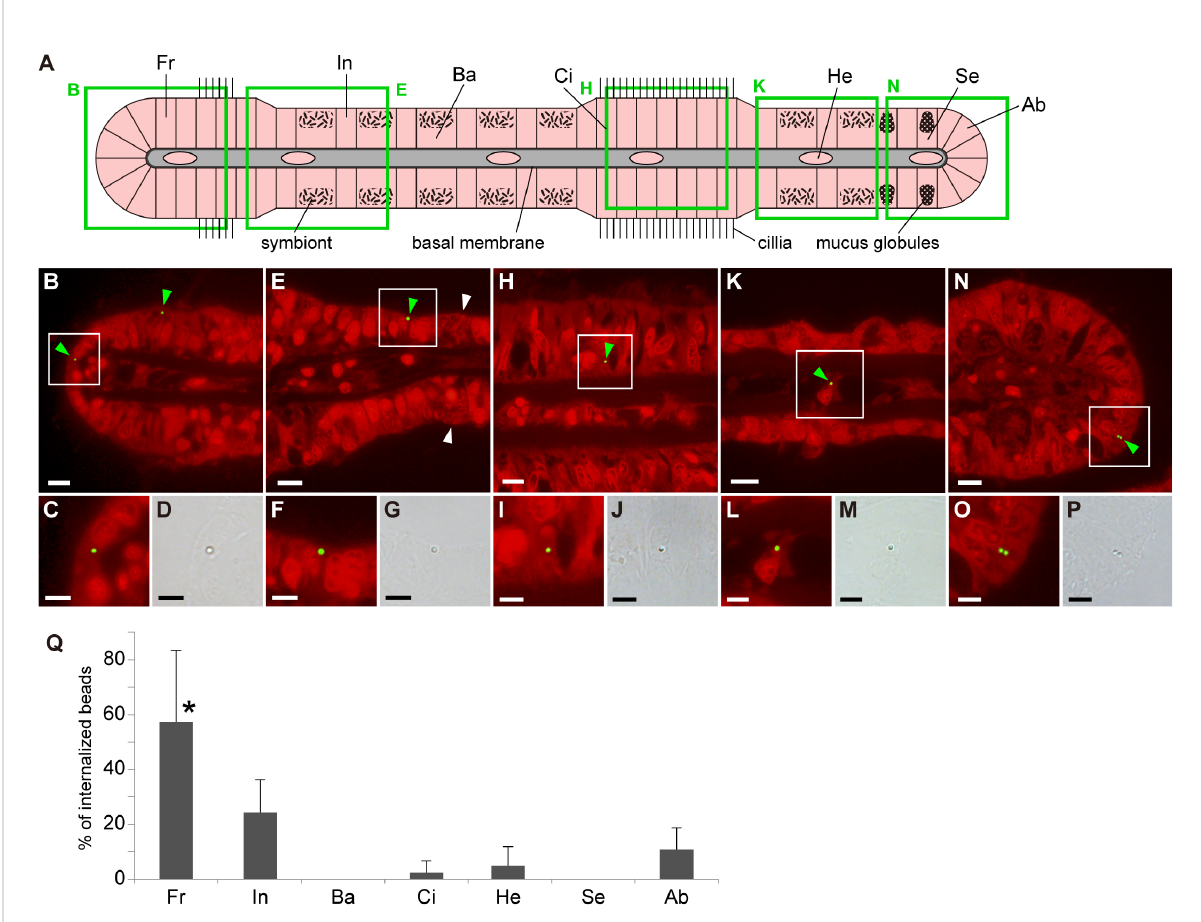
FIGURE 1 Distribution of internalized beads in various gill cell types of Bathymodiolus japonicus . (A) Schematic representation of a transverse section of a gill fi lament showing different cell types. Fr, frontal cell; In, asymbiotic intercalary cell; Ba, bacteriocytes harboring symbiotic bacteria; Ci, cell in ciliated junction; He, hemocyte; Se, secretory cell with mucus globules; Ab, abfrontal cell. Green squares indicate the areas shown in (B, E, H, K, N) . (B – P) Fluorescent and bright- fi eld micrographs showing the internalization of beads into the fi ve cell types. In fl uorescence images, propidium iodide-stained red fl uorescence (strong signals from nuclei and symbiotic bacteria and weak signal from cytoplasm) and bead- stained green fl uorescence were merged. Green and white arrowheads indicate internalized beads and symbiotic bacteria, respectively. White squares in (B, E, H, K, N) correspond to the locations of the magni fi ed fl uorescence and bright fi eld images shown below them. Scale bars: 10 µm in (B, E, H, K, N) ; 5 µm in (C, D, F, G, I, J, L, M, O, P) . (Q) Average proportion of the number of beads internalized in each cell type per total number of internalized beads. Asterisk indicates a signi fi cant difference among cell types ( P < 0.05), with error bars representing standard deviation (n =